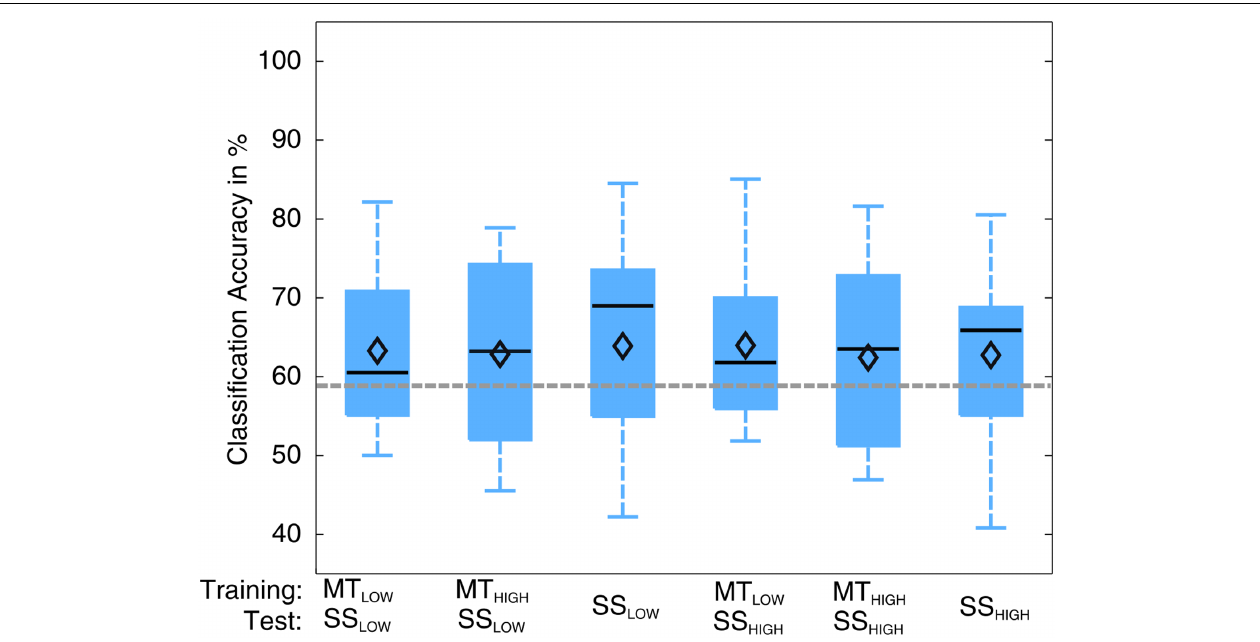
FIGURE 8 | Box plots depicting the results of the cross-classification (CC) using sensory stimulation (SS) trials as input for classifiers trained on the classification of MT trials. The abscissa shows the classifications that were performed. The upper row denotes the trials that were used in the training step; the lower row denotes the trials that were used in the testing step, i.e., evaluation of the classification performance. Third and sixth boxplots depict the regular SS classifiers that serve as controls. All CCs performed significantly above chance level ( p < 0.05). There was no significant difference in performance of any of these classifications ( p = 0.97). CCs were able to perform classification as good as the regular classifiers (RCs) that were specifically trained to distinguish SS trials from rest trials. The vertical dotted gray line depicts the statistical chance level (58.9%). Mean classification accuracies are depicted by the diamond. Central lines within the boxes represent the median.